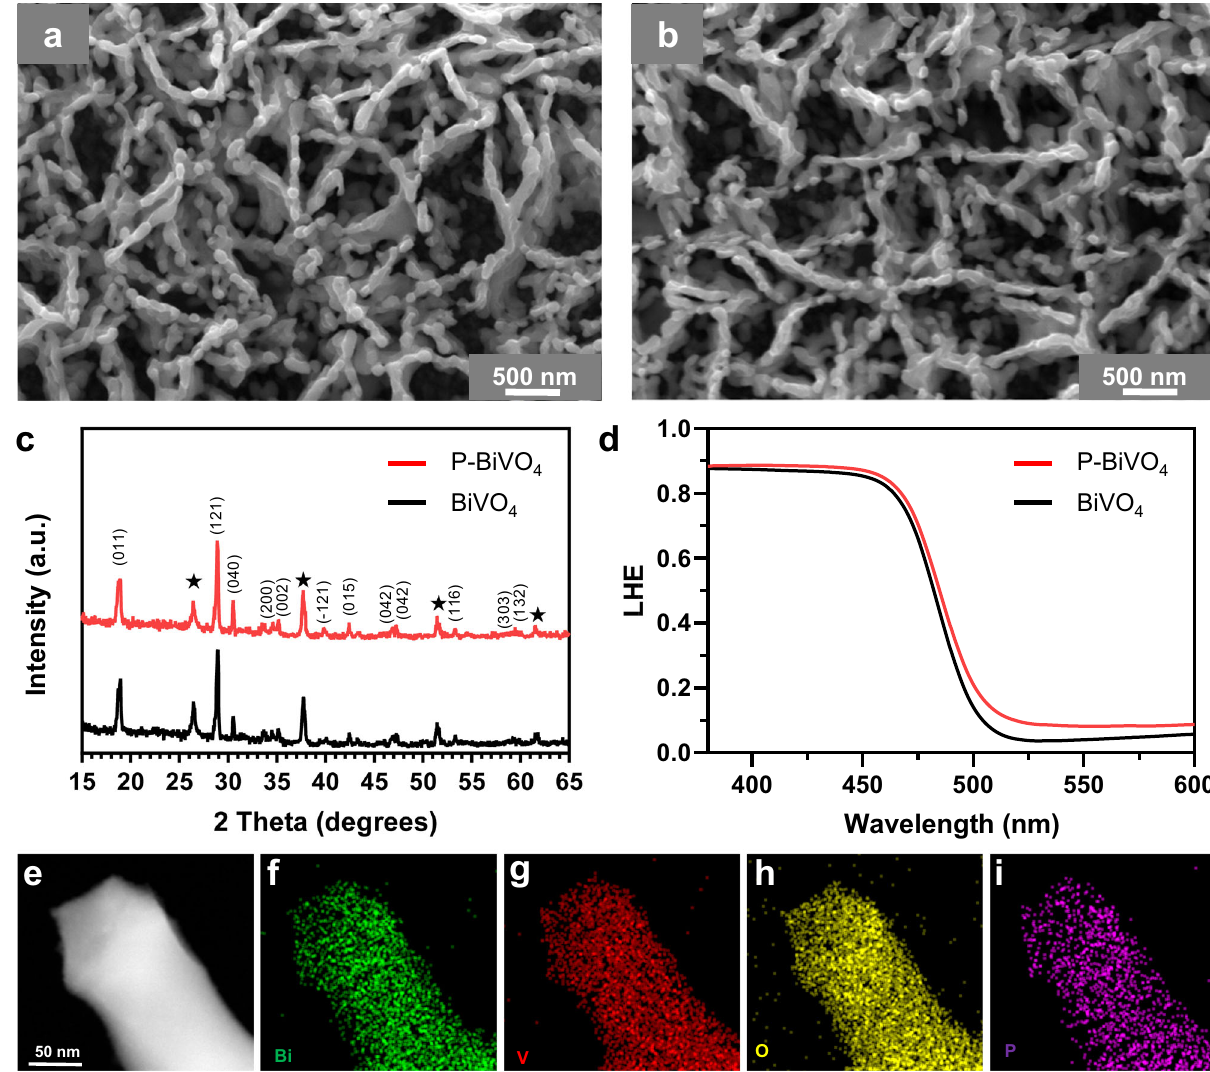
Fig. 1 | Morphological and optical characterizations. Scanning electron micro- scopy (SEM) image of a the pristine BiVO 4 and b the phosphorus-doped BiVO 4 sample(P-BiVO 4 -1mg). c X-raydiffractionpatternsand d lightharvestingef fi ciency (LHE) derived from the UV-vis absorption spectra of the BiVO 4 and phosphorus-